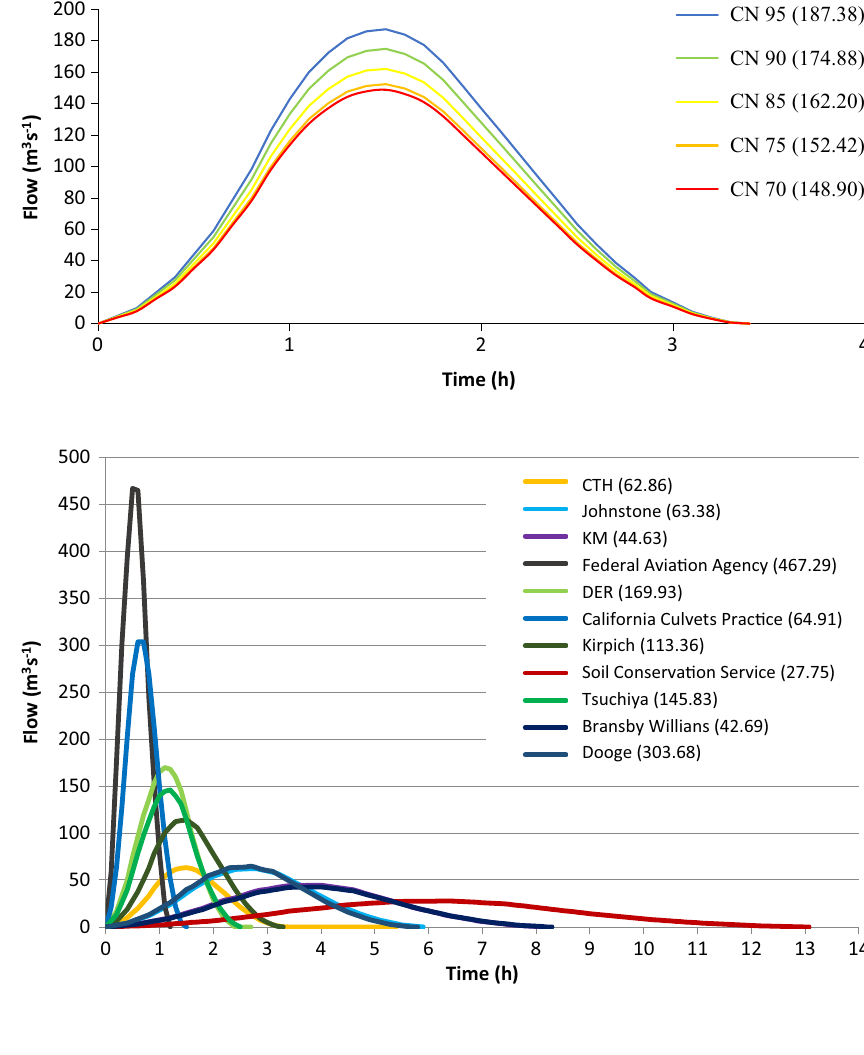
Fig. 3 Unit hydrograph of the runoff sensitivity analysis according to CN (Peak value) for Tr = 1.30 h, Ribeirao do suru watershed. Santana de Parnaiba,